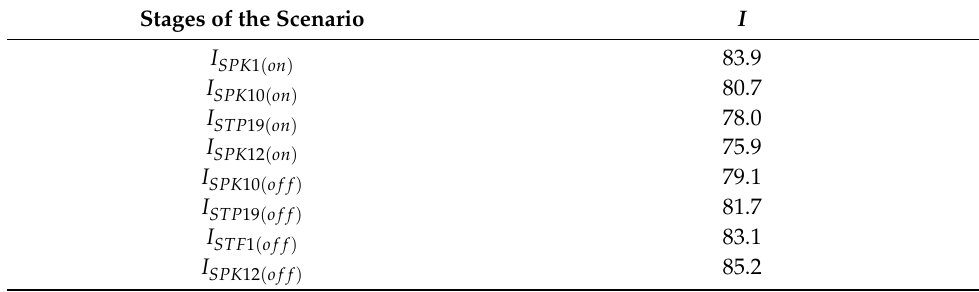
Table 6. Asset Converged Resilience Calculation for Individual Security Types.